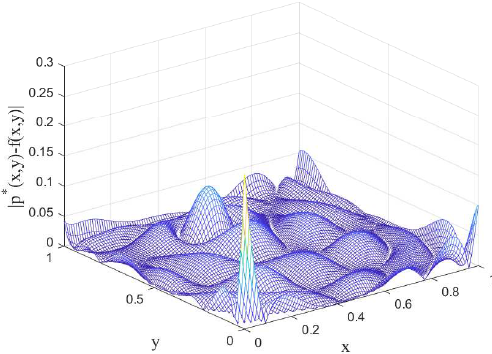
Figure 12. The error function | p ∗ ( x , y ) − f ( x , y ) | on [ 0,1 ] × [ 0,1 ]